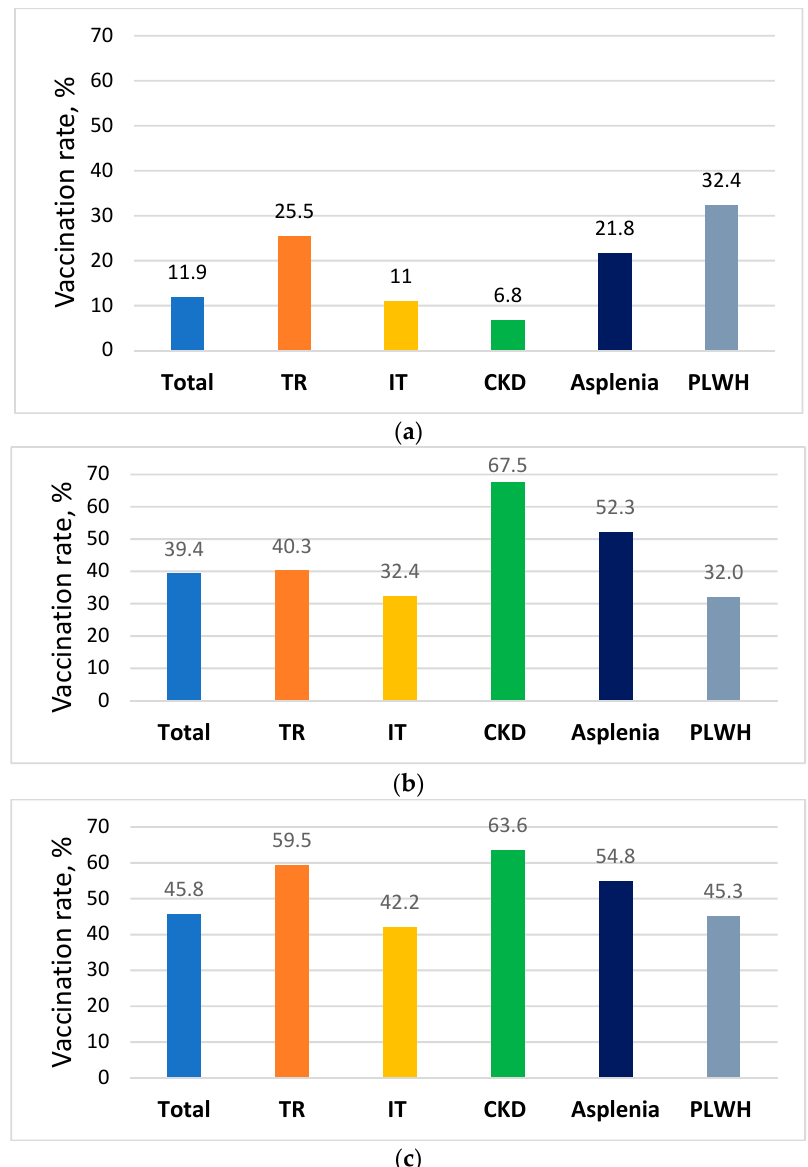
Figure 2. Pneumococcal and influenza vaccination rate uptake among immune-compromised patients in the immunocompromised registry, Israel, October 2019. ( a ) PCV13—pneumococcal conjugate vaccine; ( b ) PPV23—pneumococcal polysaccharide vaccine; ( c ) influenza seasonal vaccine, 2018–2019. Total immunocompromised patient registry, N = 32,637; TR—transplant recipients n = 1824; IT—immunosuppressive therapy, n = 23,216; CKD—advanced chronic kidney disease (GFR < 30 mL/min), n = 5462; asplenia n = 2354; PLWH—patients living with HIV, n =